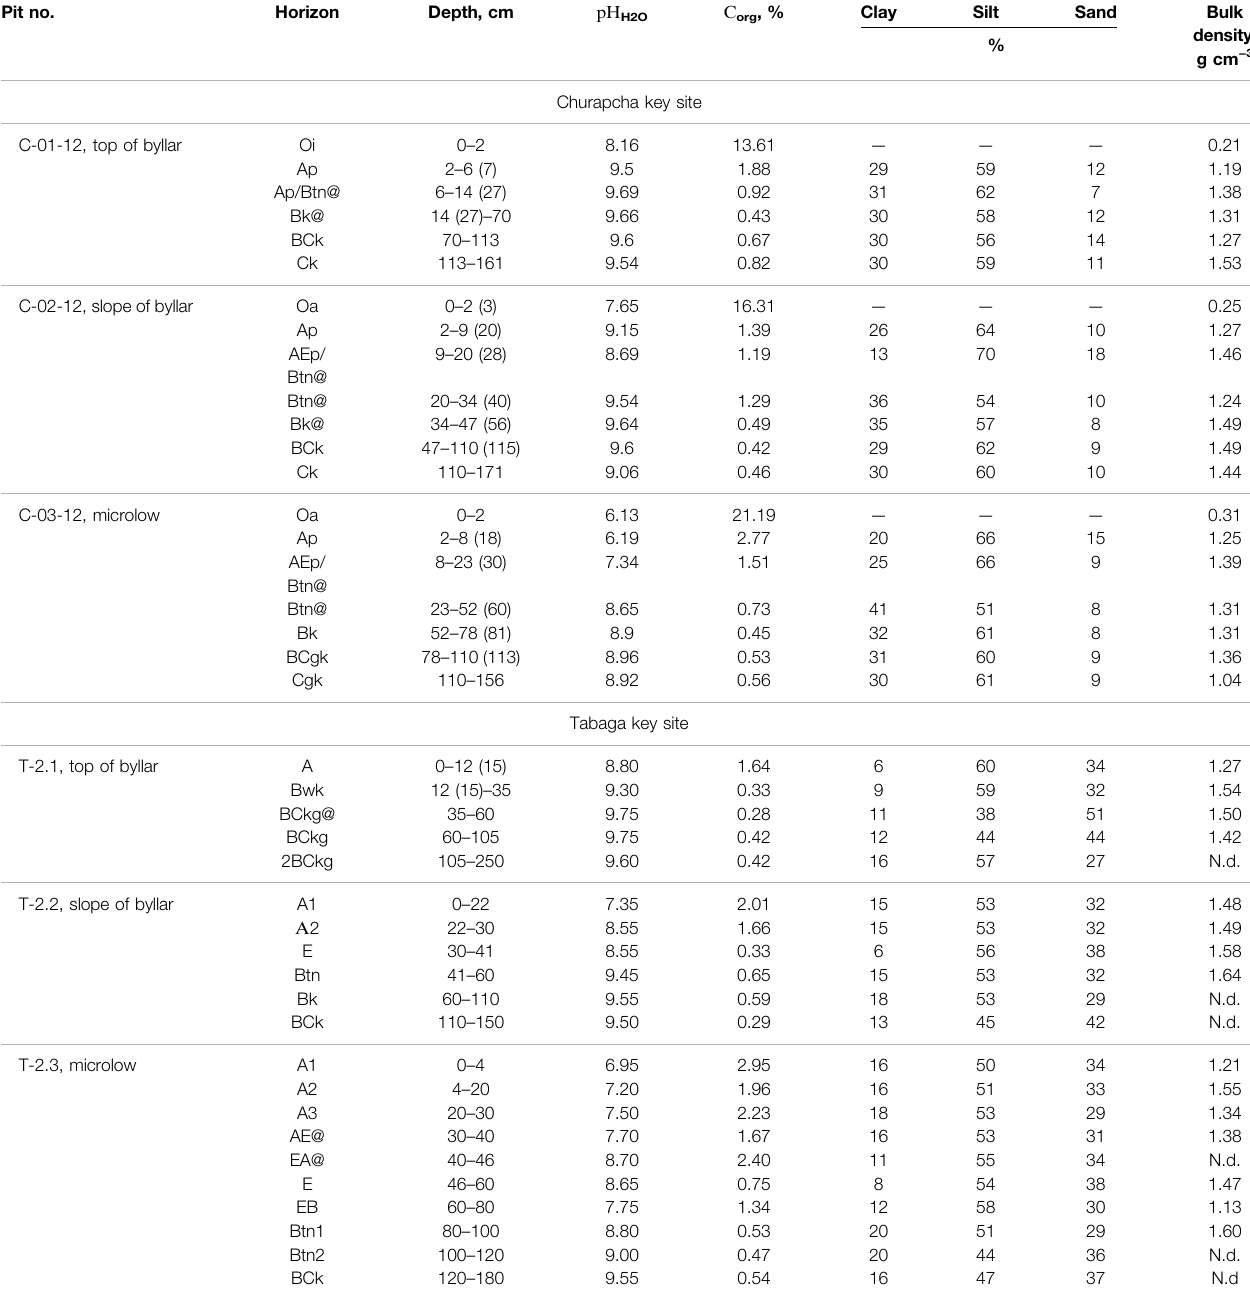
TABLE 1 | Laboratory data on soil samples from the Churapcha and Tabaga key sites. Pit